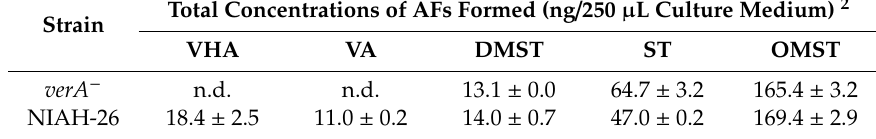
Table 3. Feeding experiments of verA deletion mutant or NIAH-26 with some precursors of aflatoxins 1 .